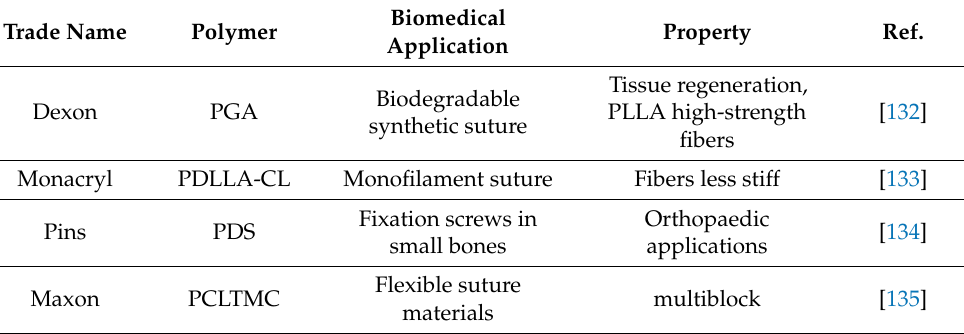
Table 2. Selected examples of commercially used scaffolds for bone/cartilage and neural tissue engineering applications from